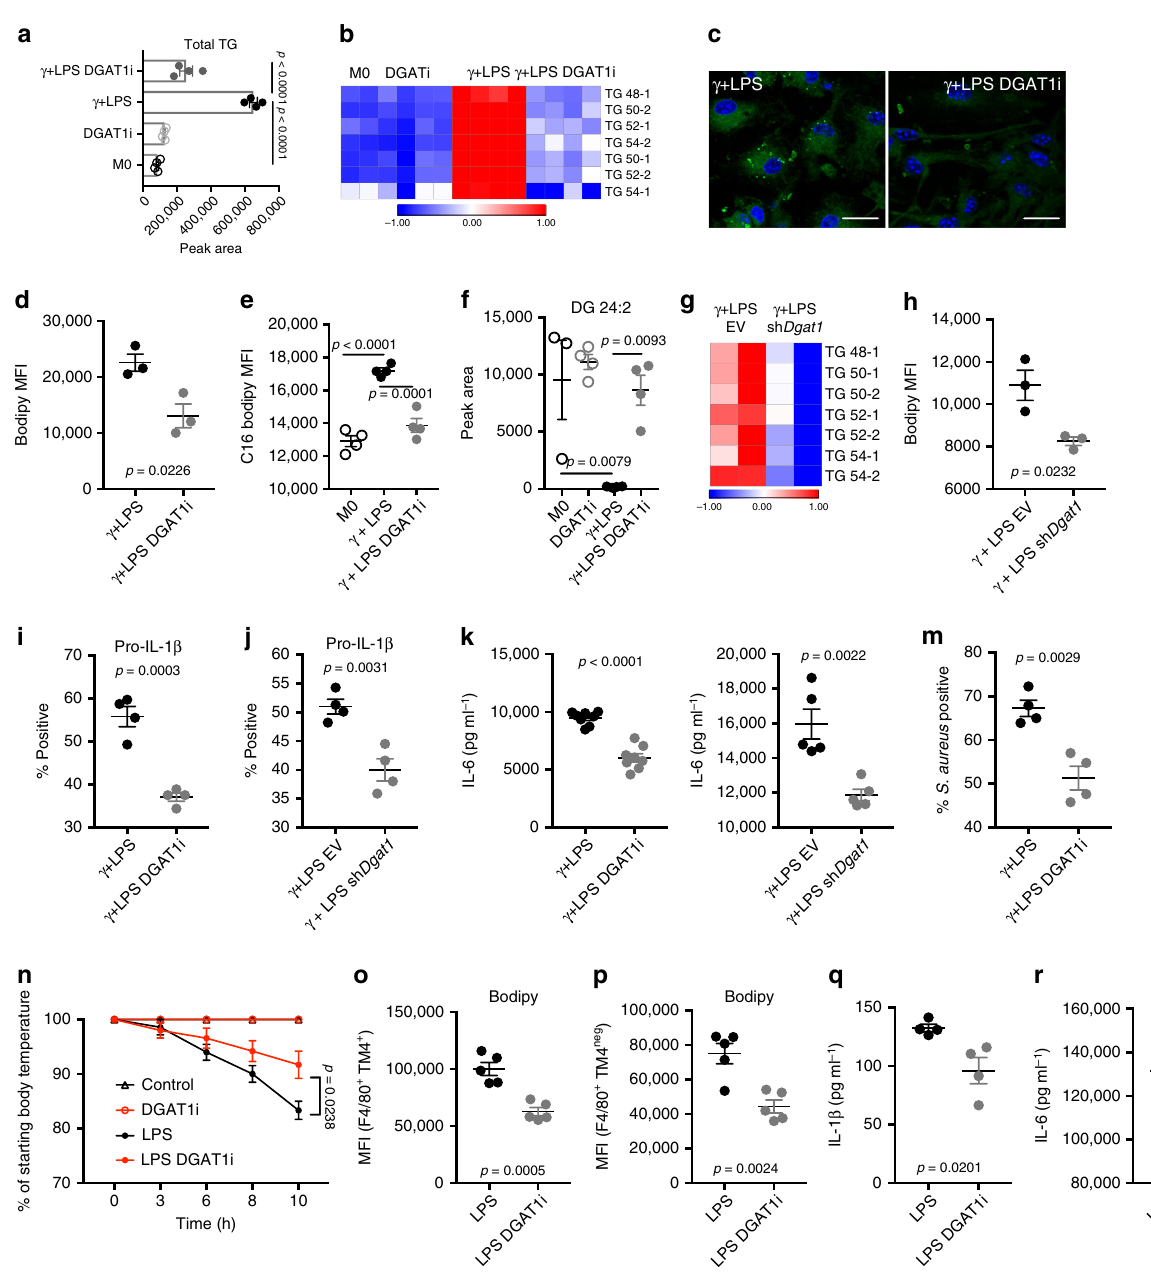
Fig. 2 The loss of DGAT1 function decreases TG accumulation, LDs, and in fl ammatory function. a Effect of DGAT1 inhibitor T863 (DGAT1i) on total TG, and b distinct TG species ( n = 4 biologically independent samples) in resting (M0) and macrophages stimulated with IFN γ + LPS. c Bodipy 493/503 fl uorescence visualized by fl uorescence microscopy (scale bars represent 10 μ m) or d measured by fl ow cytometry (MFI, median fl uorescence intensity) ( n = 3 biologically independent samples). e C16 Bodipy uptake ( n = 4 biologically independent samples). f Effect of DGAT1i on DG levels in M0